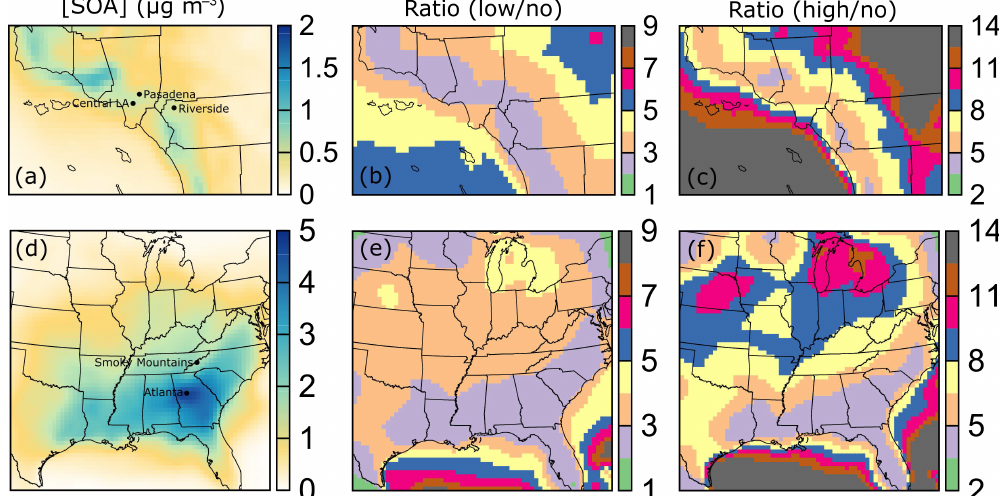
Figure 1. 14-day averaged SOA concentrations, in µgm − 3 , for (a) SoCAB and (d) the eastern US for the SOM-no simulations. The averaging time periods are from 20 July to 2 August 2005 for SoCAB and from 20 August to 2 September 2006 for the eastern US. Panels (b, e) show the ratio between the SOA concentrations for the SOM-low and the SOM-no simulations and panels (c, f) show the ratio between the SOM- high and SOM-no simulations. Results shown in all panels are the average of the low- and high-NO x simulations. Note that the color scale for the absolute SOA concentration is continuous whereas the color scale in the ratio plots is